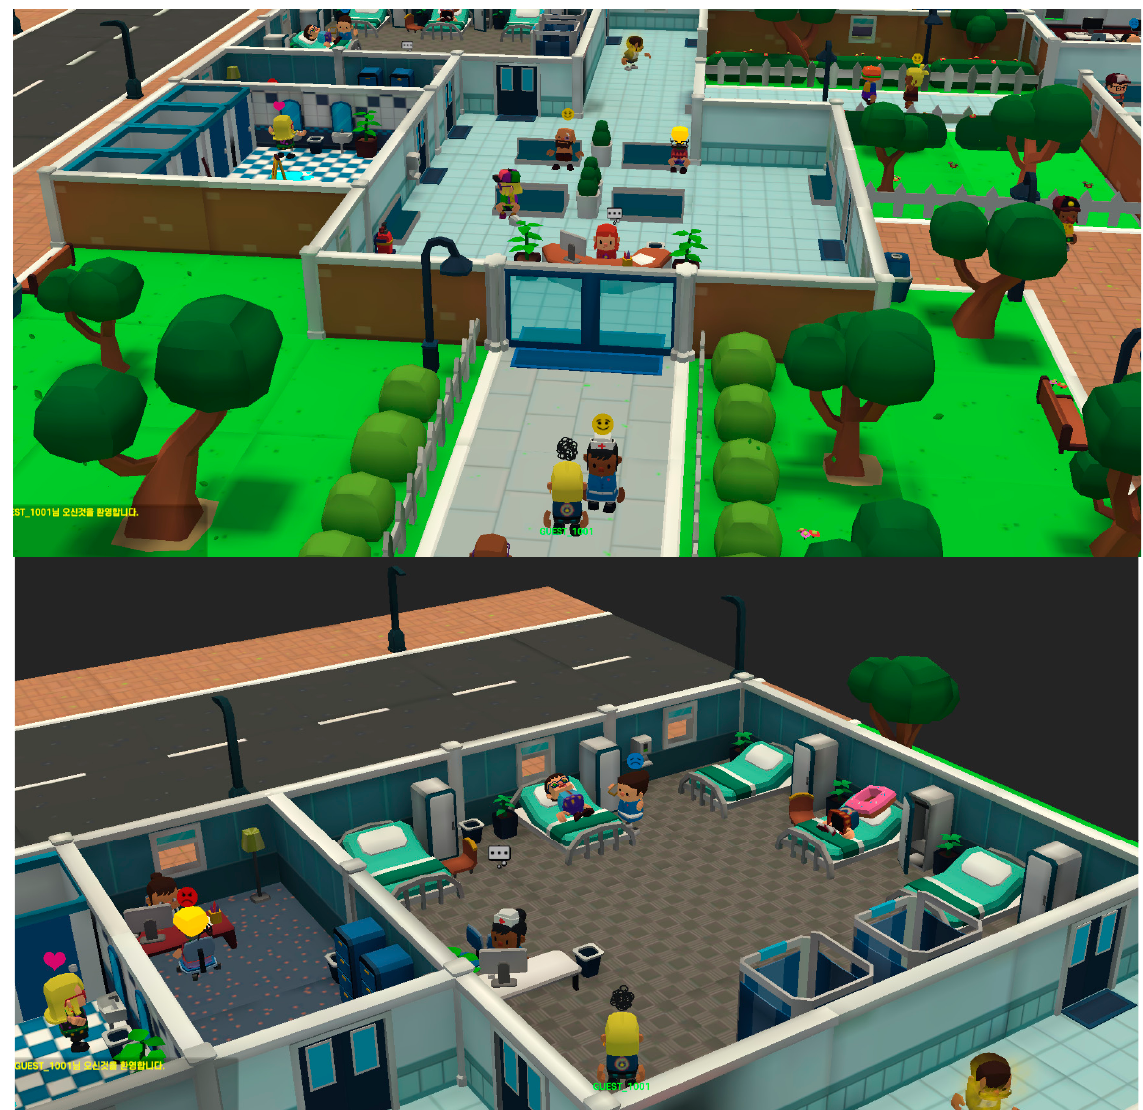
Figure 1. Metaverse rehabilitation.